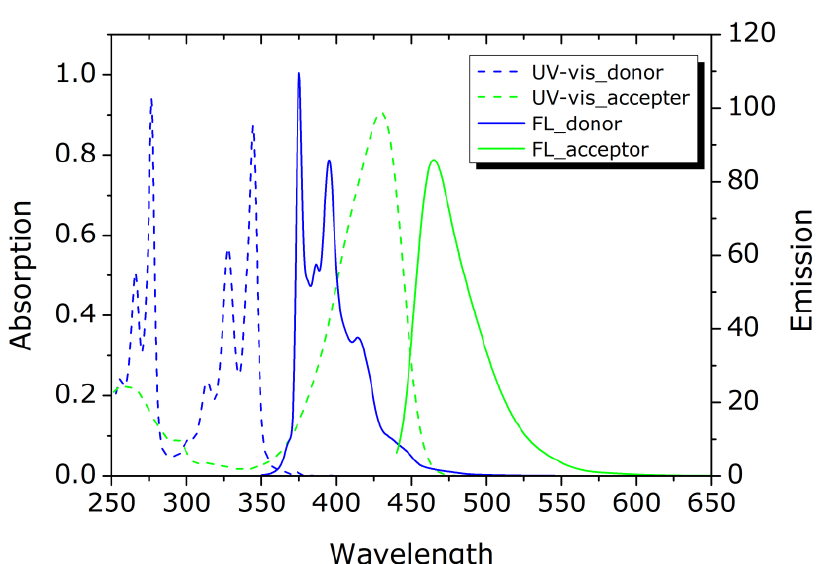
Figure 2. The emission spectrum of the donor molecule and the absorption spectrum of the accep- tor of FRET polymer.